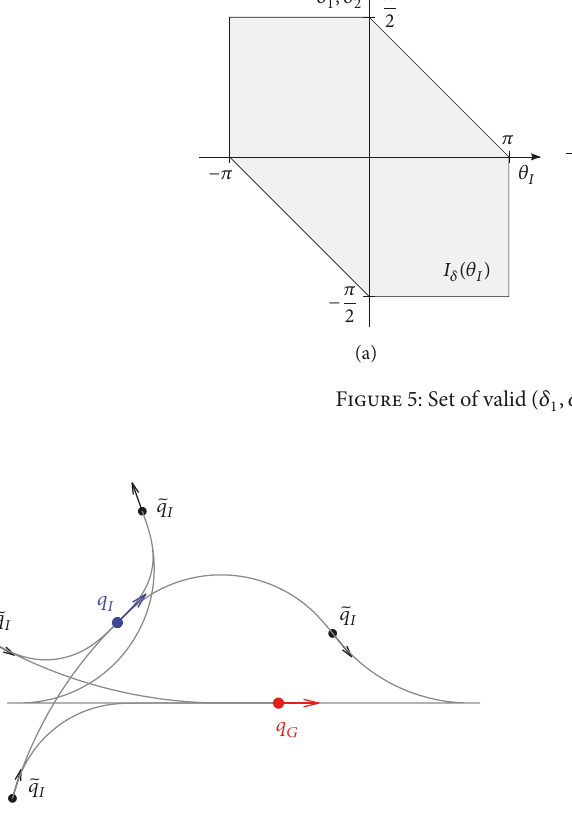
Figure 6: There is an infinite number of TTS solutions between two